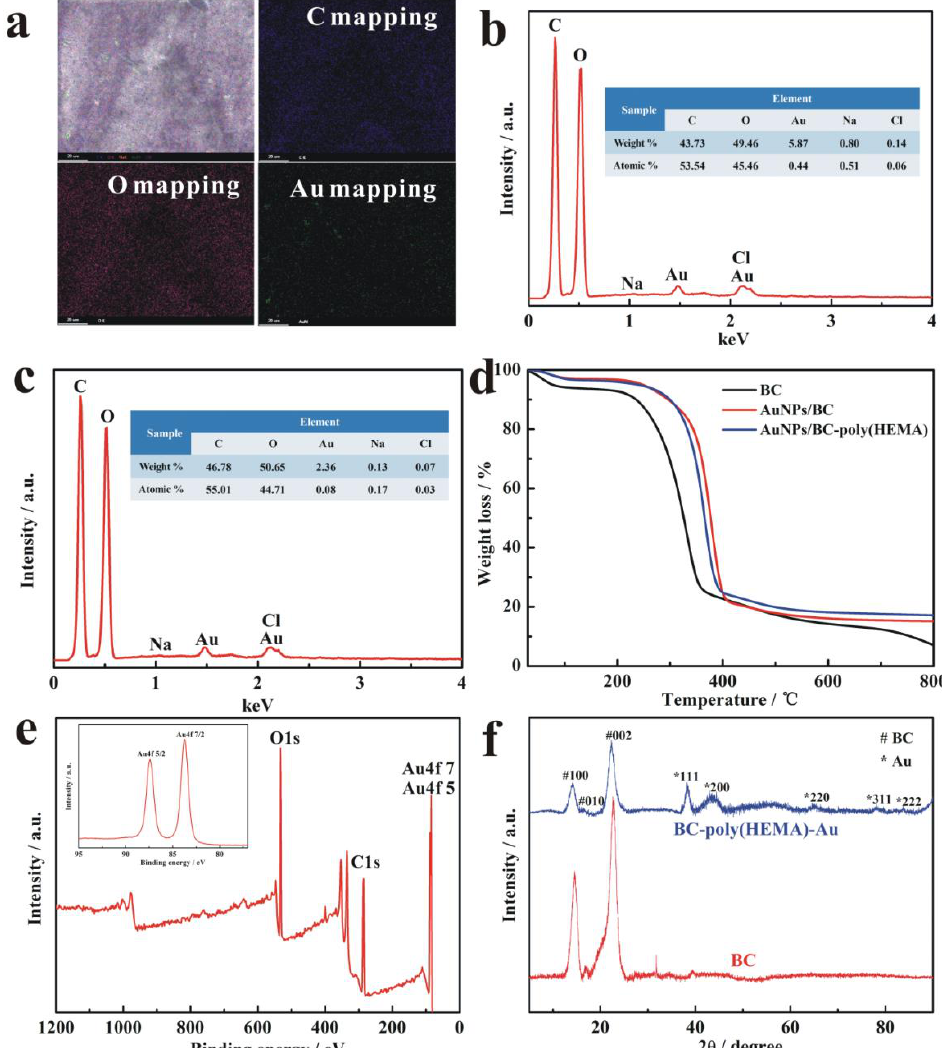
Figure 5. SEM-EDS elemental mapping images of AuNPs/BC-poly(HEMA) ( a , b ) and AuNPs/BC ( c ); ( d ) TGA curves of BC, AuNPs/BC and AuNPs/BC-poly(HEMA); ( e ) XPS spectrum of high-resolution C/O/Au on AuNPs/BC-poly(HEMA); ( f ) X-ray diffraction (XRD) patterns of AuNPs/BC-poly(HEMA).